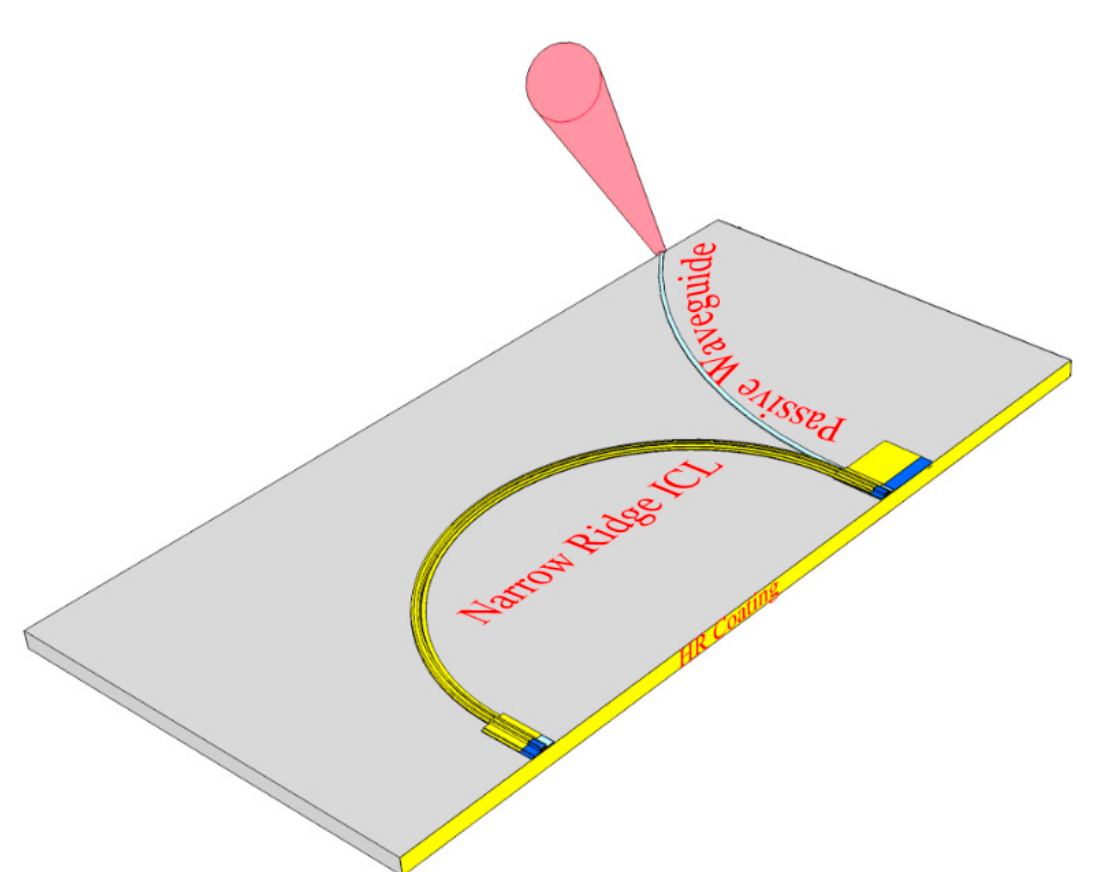
Figure 8. Schematic of a curved laser cavity with laterally coupled output and both end mirrors provided by the same HR-coated facet.